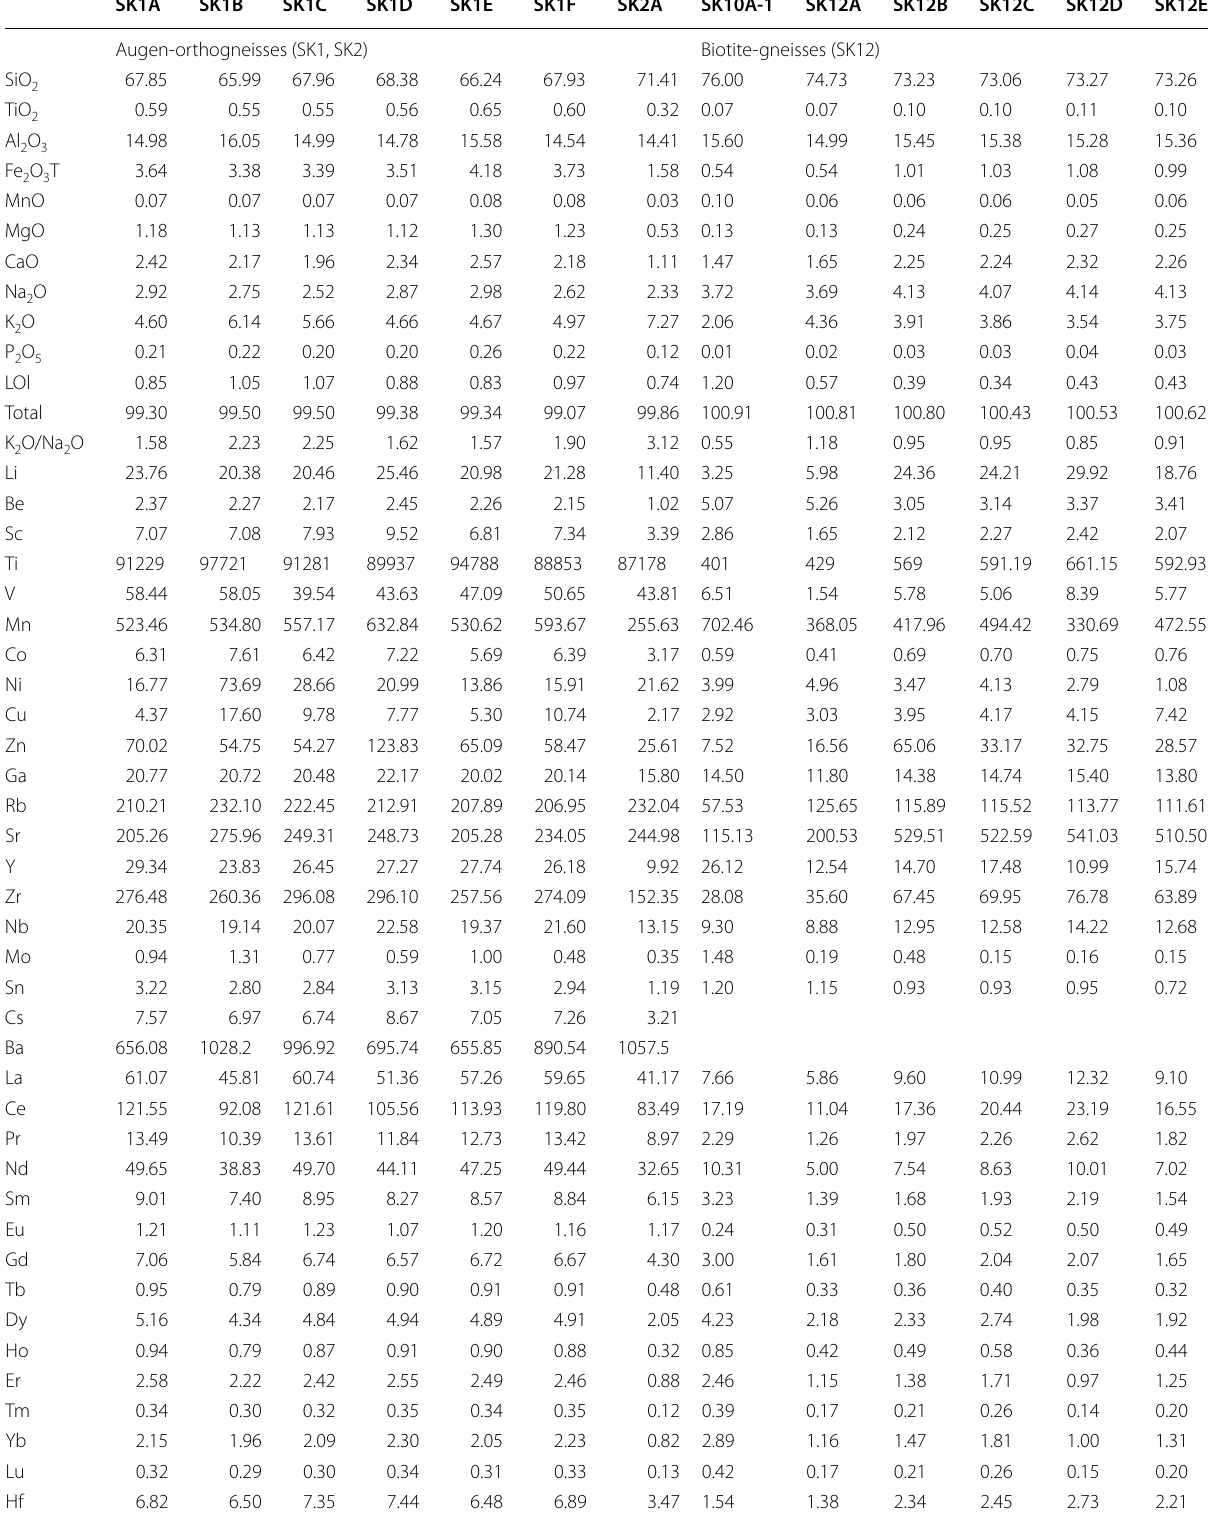
Table 3 Whole-rock major and trace element data of the Pohorje